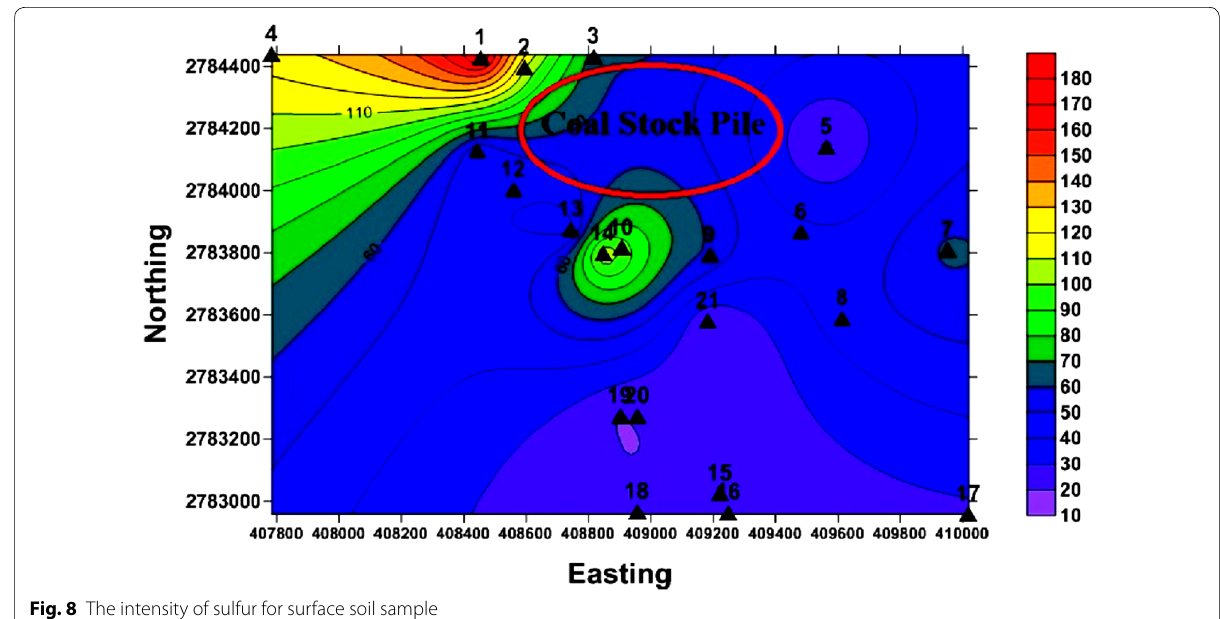
Fig. 8 The intensity of sulfur for surface soil sample